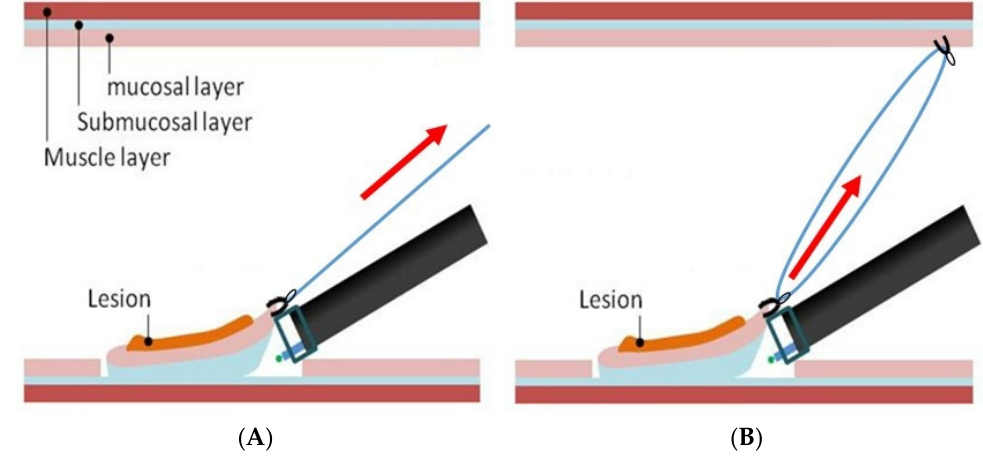
Figure 4. Method of traction-assisted ESD. ( A ) The thread-and-clip method. The clip is attached to the proximal lesion and the end of the thread is pulled to enable the lifting of the lesion; ( B ) The clip-and-ring-thread method. It can help pull the lesion to the intended direction to set a traction force.